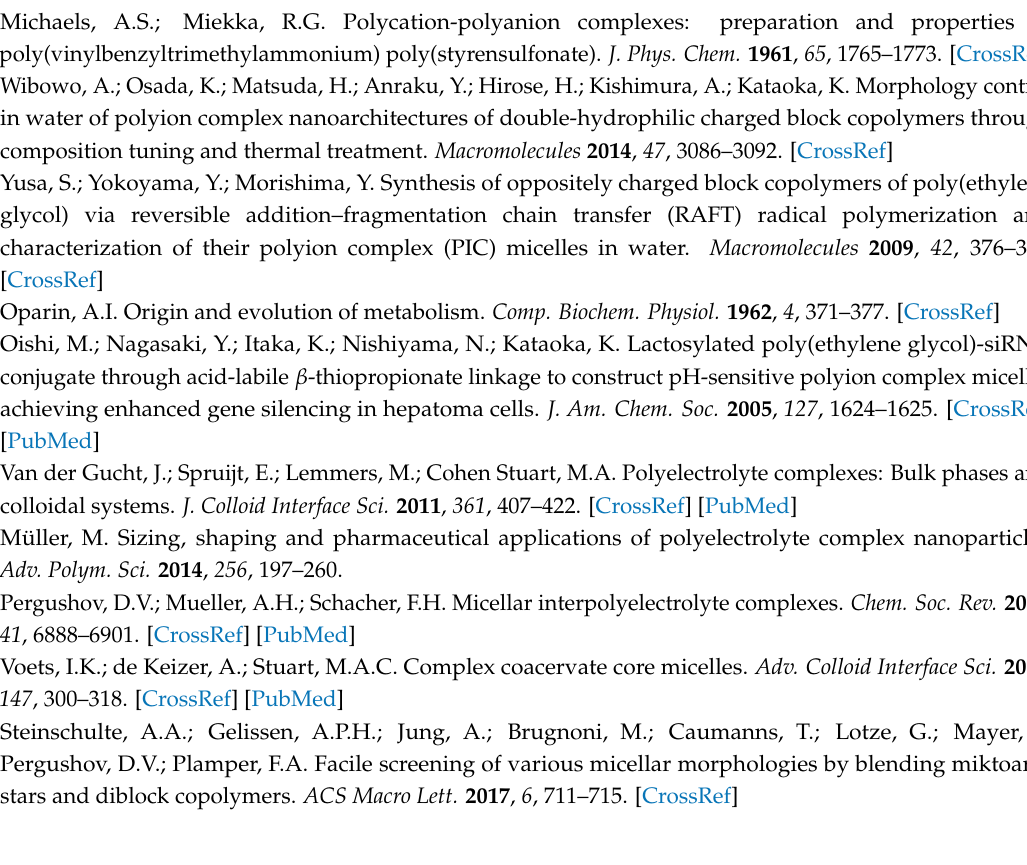
micelles at C p = 1 g/L in 0.1 M aqueous NaCl at 25 ◦ C; Figure S5: Hydrodynamic radius ( R h , ) and light scattering intensity (LSI, (cid:52) ) of PIC micelles as a function of polymer concentration ( C p ) in 0.1 M aqueous NaCl. Figure S6: Relationship between R h ( ) and light scattering intensity (LSI, (cid:52) ) as a function of time for PIC micelle with f + = 0.5 at C p = 1.0 g/L in 0.1 M NaCl aqueous solution; Figure S7: A typical Zimm plot for PIC (cid:35) ) and light scattering